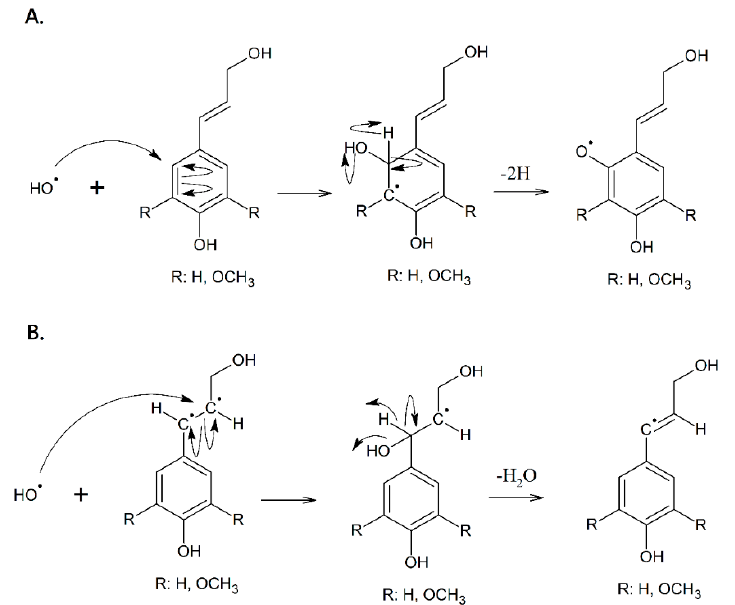
Figure 5. Formation of lignin radicals. Lignin radicals formed by attacking the aromatic ring ( A ) and by attacking the alkene group ( B ) have the capacity to create intramolecular interactions with other lignin radicals or intermolecular interactions with glycine. Authors are aware that there might be more possible reaction mechanisms than the one shown in this figure.